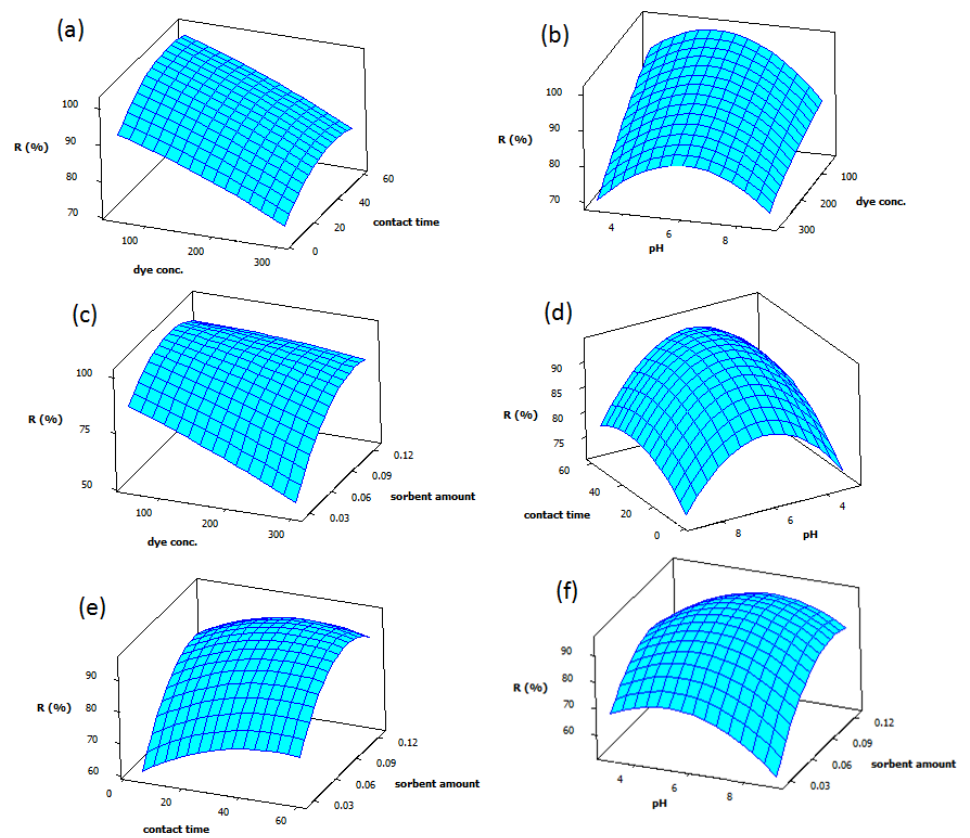
Fig. 7. Response surface plots of the predicted MO removal percentage as a function of (a) contact time and dye concentration, (b) pH and dye concentration, (c) sorbent amount and dye concentration, (d) contact time and pH, (e) contact time and sorbent amount, and (f) pH and sorbent amount, keeping other variables at central point